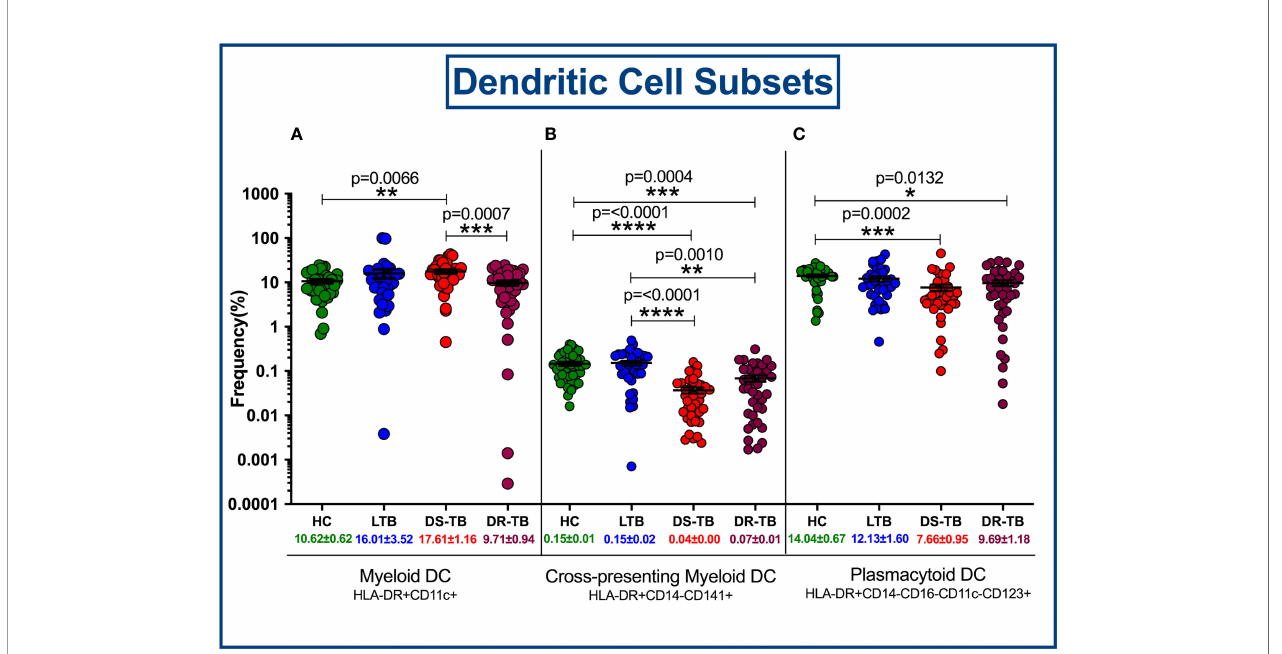
FIGURE 5 | Frequency distribution of dendritic cell subsets; HLA-DR + CD11c + myeloid DCs (A) , Cross-presenting myeloid DCs (B) and Plasmacytoid DCs (C) among four groups. p value less than 0.05 is considered as statistically signi fi cant and the level of signi fi cance denoted as * [p<0.01(*); p<0.001(**); and p<0.0001 (***)]. The signi fi cance level with their p values are mentioned in the graph. Highly signi fi cant ones are mentioned as **** where